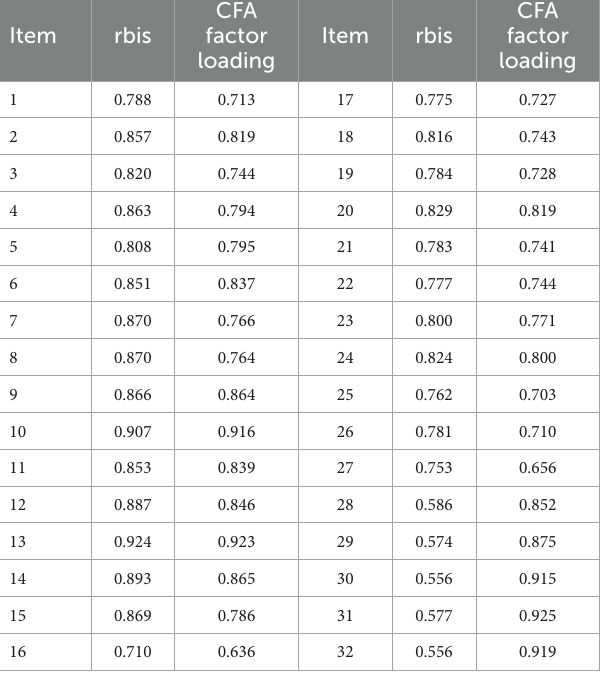
TABLE 5 Item-total correlation index and CFA factor loadings.